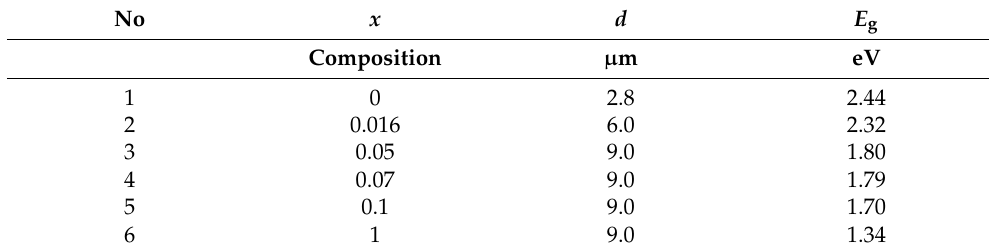
Table 1. Parameters of the investigated samples.